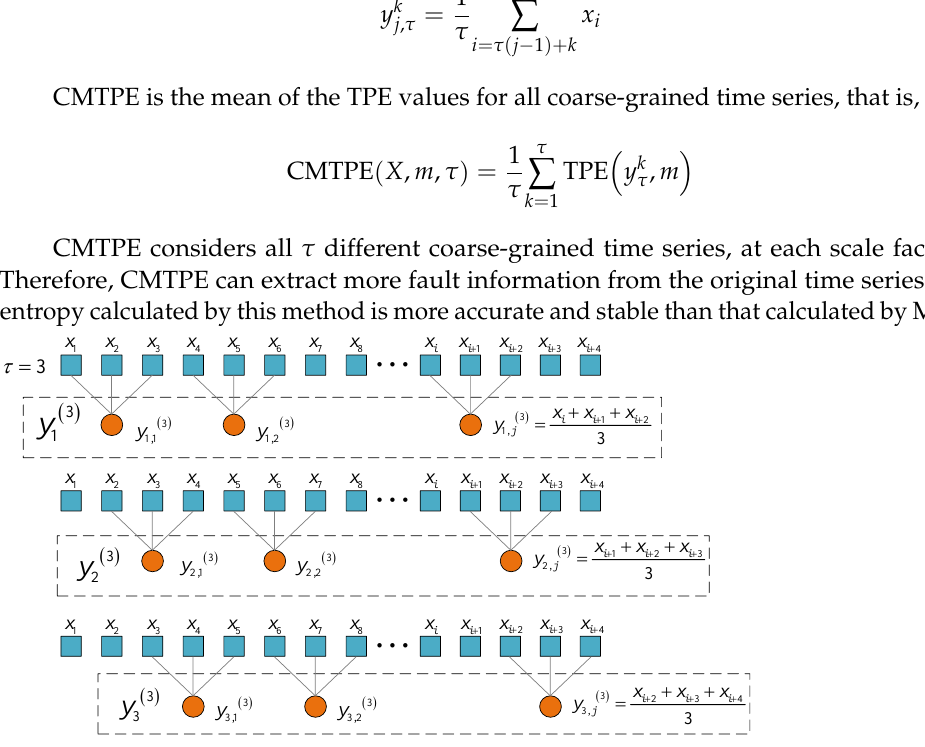
Figure 1. Schematic diagram of multiscale coarsening process when scale factor =3 .